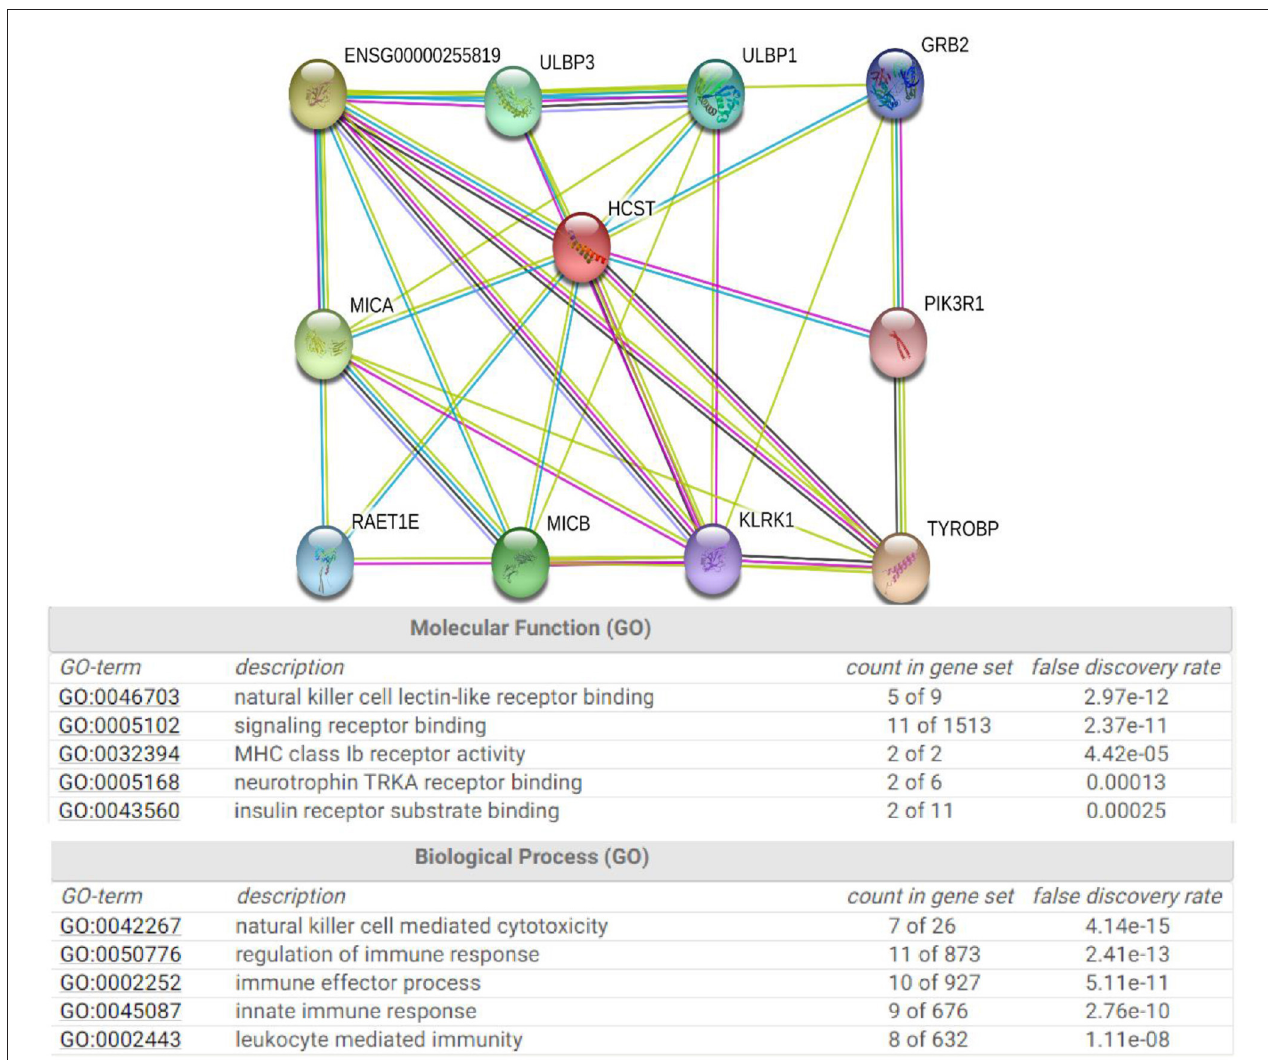
FIGURE 7 | Protein interaction network of HCST. An interaction network of the HCST protein with other proteins (i.e., TYROBP, KLRC4, MICA, MICB, ULBP3, ULBP1, RAET1E, GRB2, KLRK1, and PIK3R1). The interaction network was obtained from the STRING database.